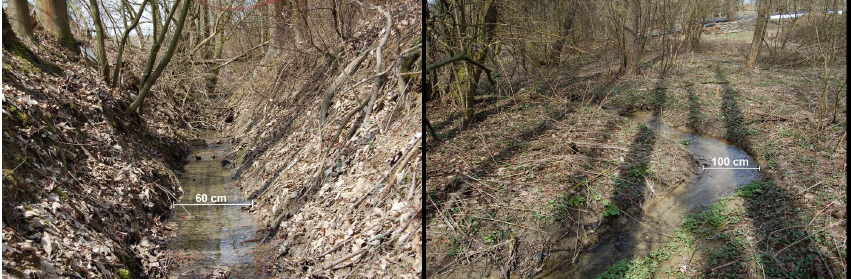
Fig. 4. Upstream section of the stream in the HOAL catchment close to the pumping station (left panel) and downstream section close to the catchment outlet (right panel). Width of stream is indicated in the photos for comparison. Both photos are upstream views.